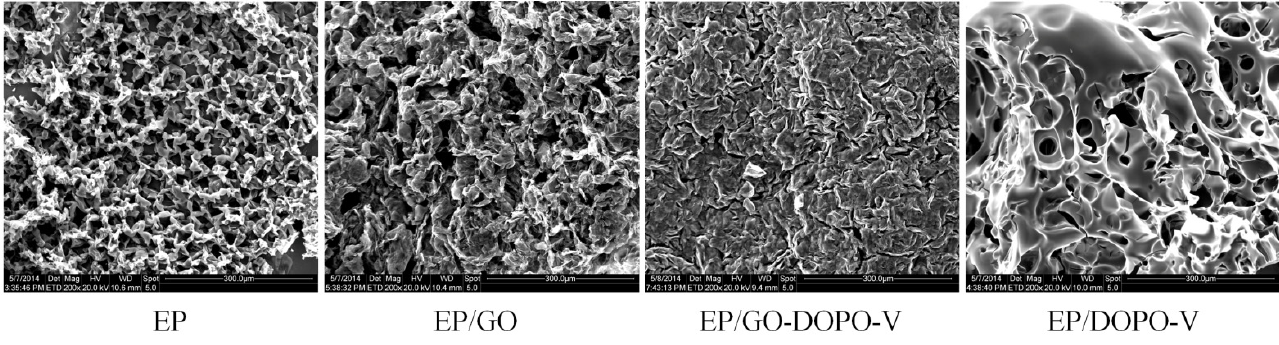
Figure 9. SEM images of residual char after CONE measurement.